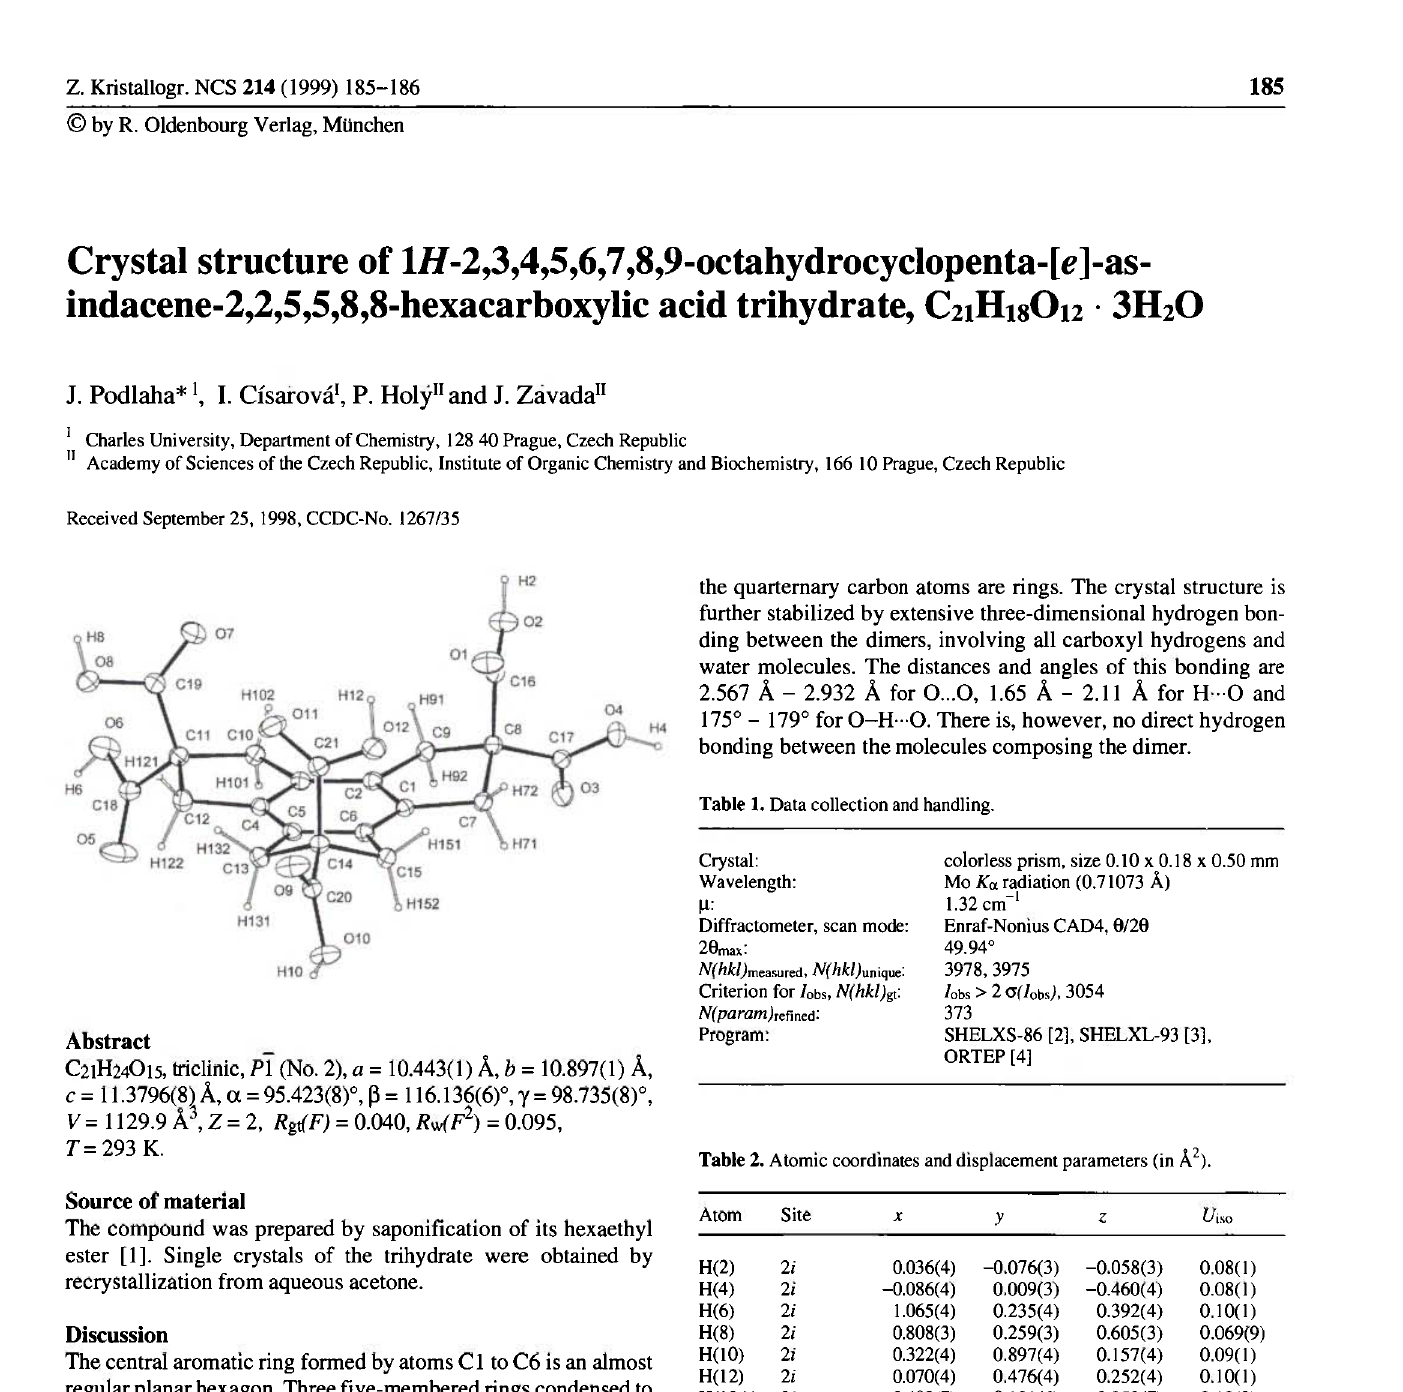
Table 2. Atomic coordinates and displacement parameters (in Ä 2